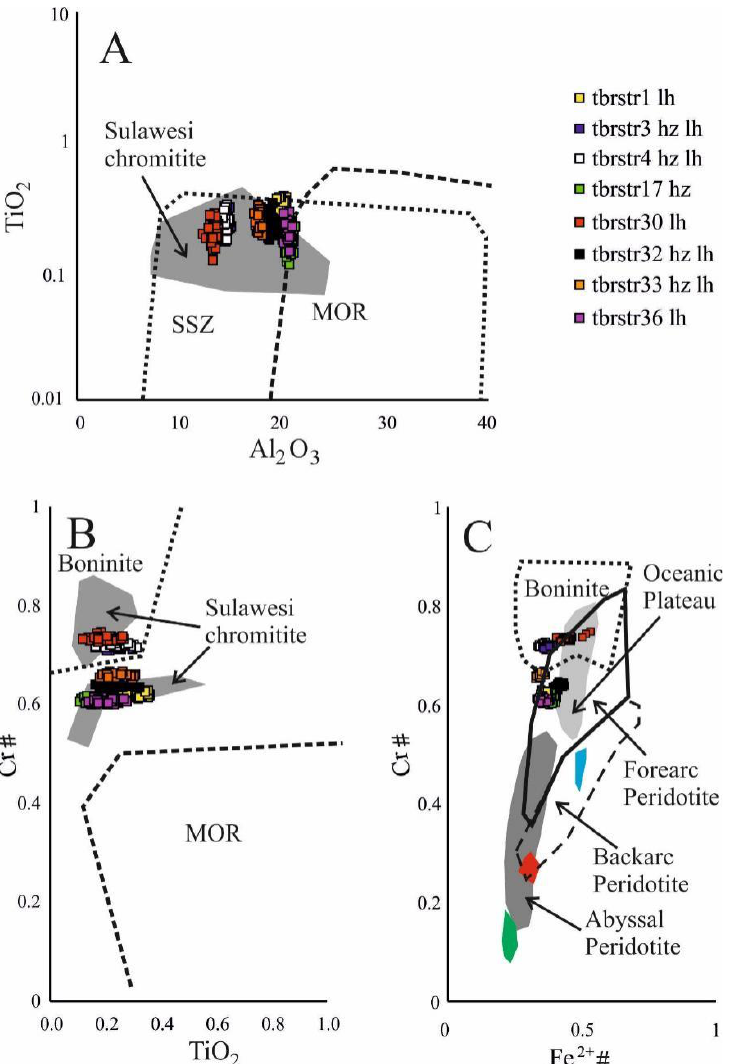
Figure 7. Composition of the chromitites from Kabaena Island compared with that from different the geodynamic setting and Sulawesi: Al 2 O 3 (wt%) versus TiO 2 (wt%) ( A ), variation of TiO 2 (wt%) and Cr# = Cr/(Cr + Al) ( B ), and correlation between Cr# and Fe 2+ # compared with the accessory spinel in the Kabaena lherzolite (green field), harzburgite (red field), and dunite (blue field) ( C ). Compositional fields from Kadarusman et al. [10], Dick and Bullen [18], Kamenetsky et al. [23], Arai [37], and Zaccarini et al. [38].